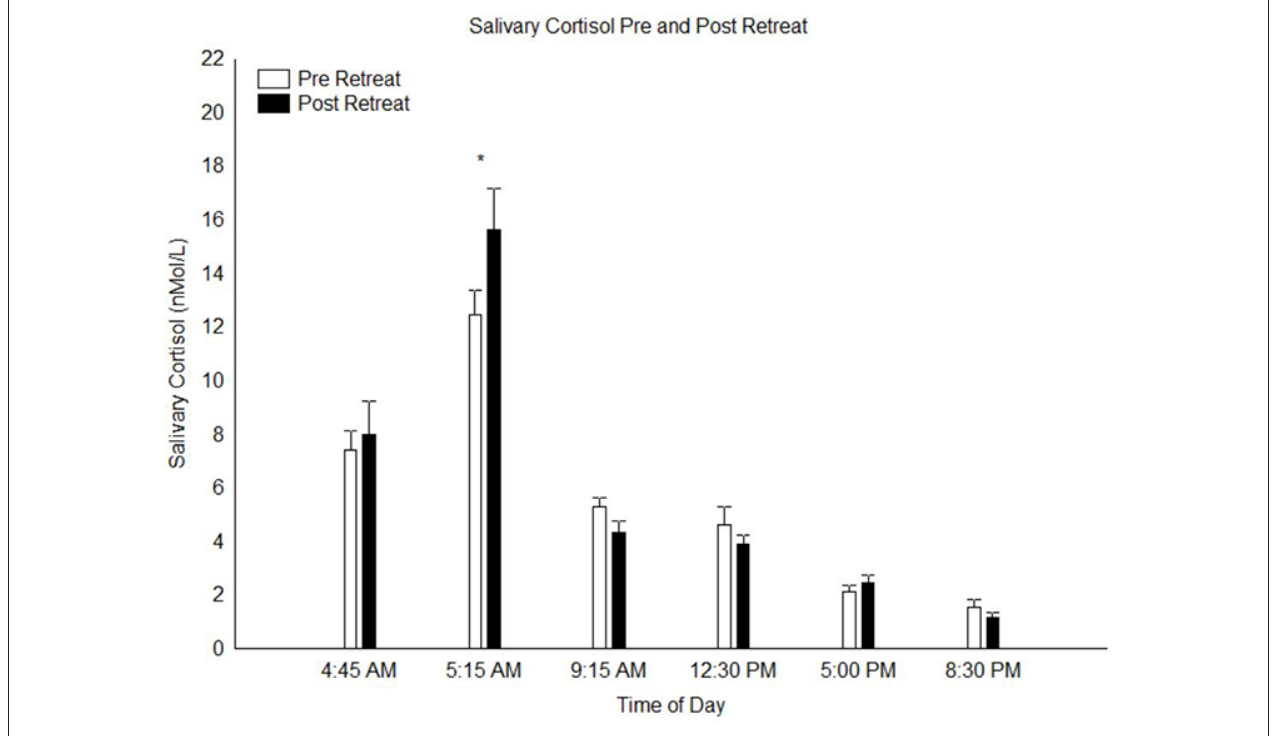
FIGURE 1 | Salivary cortisol levels throughout the day at pre- and post-retreat, N = 31. ∗ p < 0.05.